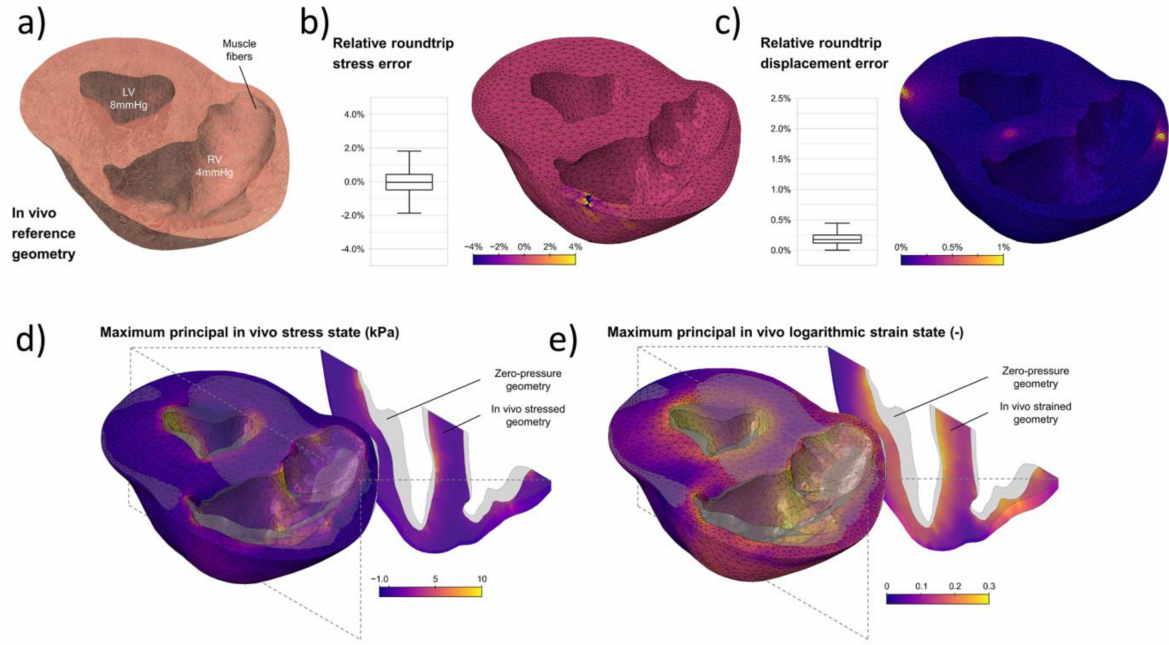
Figure 11. Results and accuracy of the direct inverse elastostatic problem implemented on a FEM solver and applied to a porcine biventricular model. ( a ) Reference loaded configuration reconstructed from MRI scans. ( b ) Relative stress error of the in vivo loaded configuration and solution of the for- ward inflation problem from the estimated unloaded configuration (roundtrip solution). ( c ) Relative displacement error the in vivo loaded configuration and solution of the forward inflation problem from the estimated unloaded configuration (roundtrip solution). ( d ) Colormap representation of the maximum principal stress distribution of the loaded configuration on top of the estimated un- loaded configuration in gray shade. ( e ) Colormap representation of the maximum principal strain distribution on top of the estimated unloaded configuration in gray shade. (Reprinted/adapted with permission from Ref. [100]. 2018,